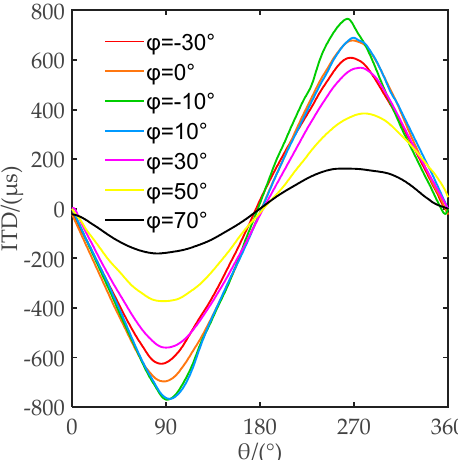
Figure 1. Average Interaural Time Difference (ITD) value of 56 subjects at different directions. The X-axis stands for the azimuths of sound source, and the Y-axis stands for the ITD value. Curves in different colors represent the ITD variation trends of sound sources with different elevations.